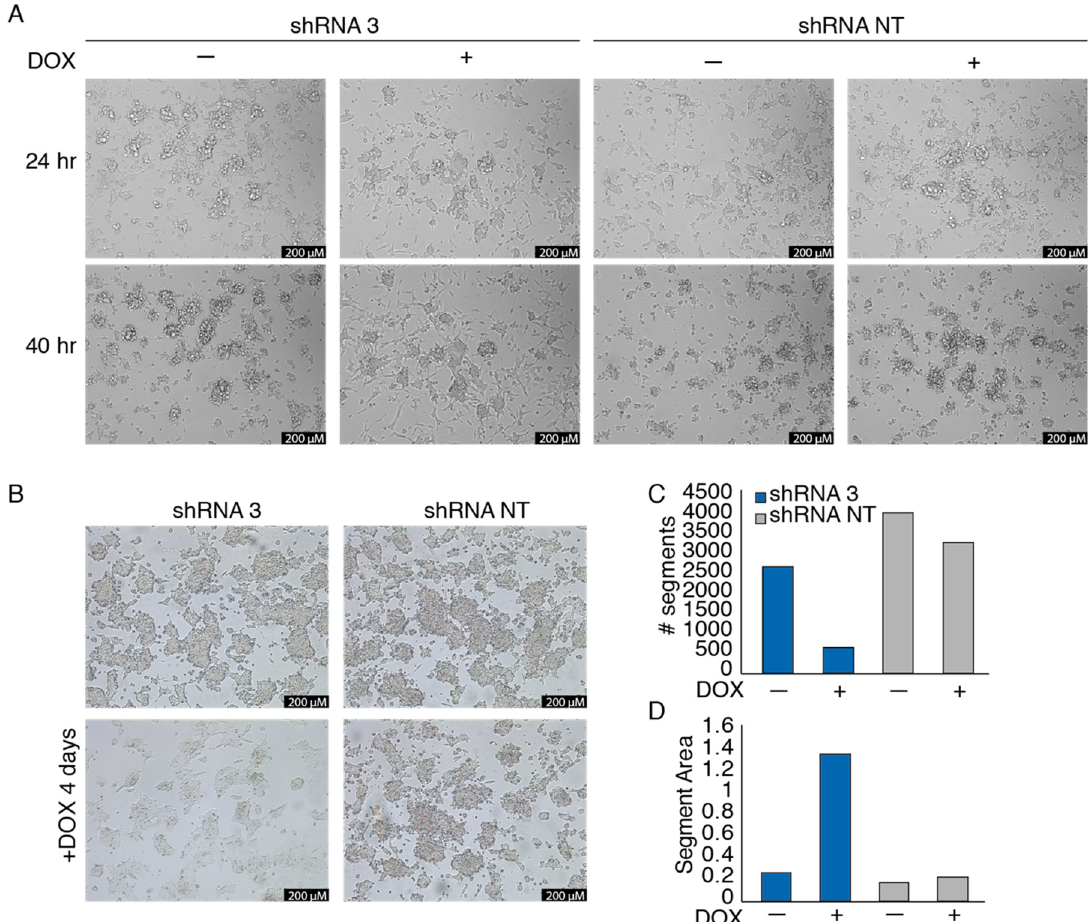
Figure 3. EWSR1-WT1 expression affects OV-054 DSRCT cell shape and propagation. ( A ) Time-lapse images of OV-054 DSRCT cells upon EWSR1-WT1 knock-down 24 and 40 h post-DOX-induction; scale bar: 200 µm. ( B ) Representative pic- tures taken 4 days post-DOX-induction of shRNA 3 and shRNA NT in DSRCT cells; scale bar: 200 µm. ( C ) Bar plot depict- ing number of segments, representing OV-054 DSRCT cells 4 days post-DOX-induction of shRNA 3 and shRNA NT, using particle analysis in ImageJ. ( D ) Bar plot depicting segment area, representing OV-054 DSRCT cells found 4 days post- DOX-induction of shRNA 3 and shRNA NT, using particle analysis in ImageJ.